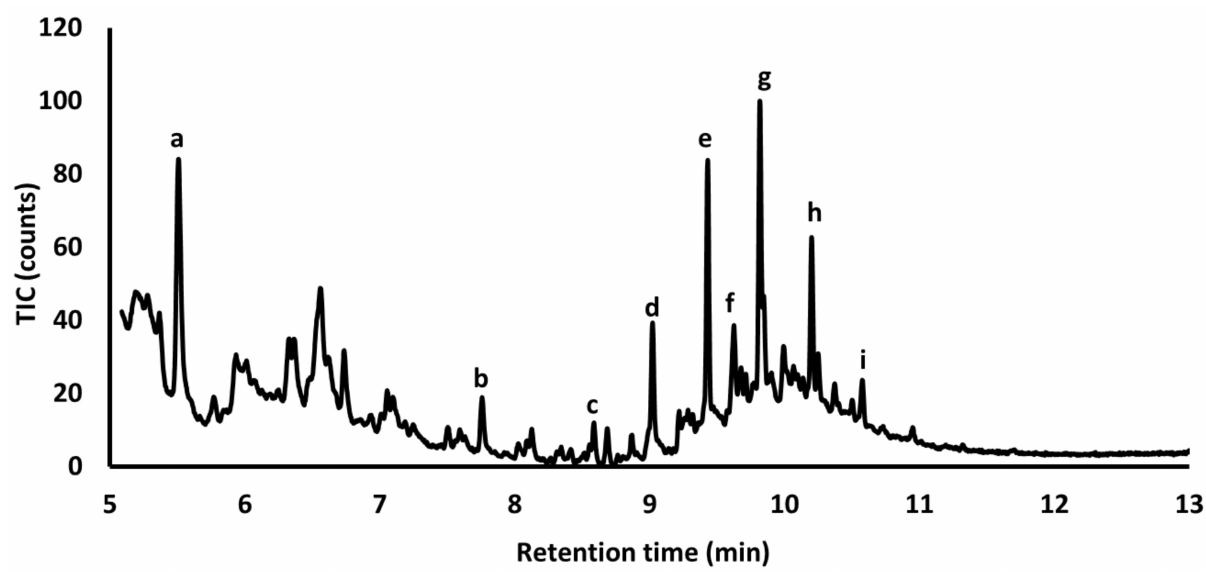
Figure 2. Pyrogram of the solid sample from mold #2 (a—furfural, b—naphtalene, c—tetradecane, d—pentadecane,